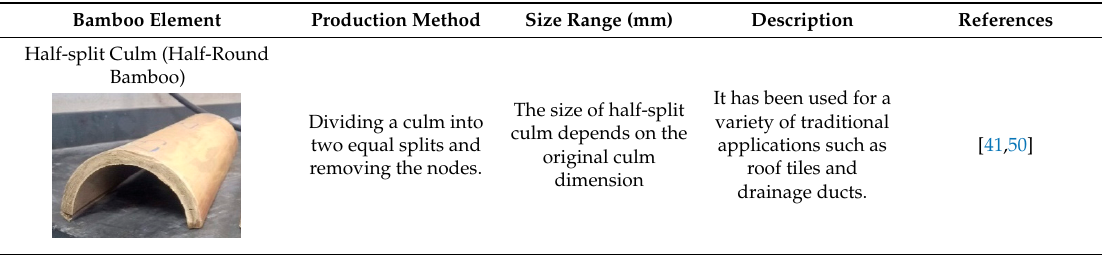
Table 1. The classification of bamboo elements used in densified products (specifically bamboo based panels (BBPs)).